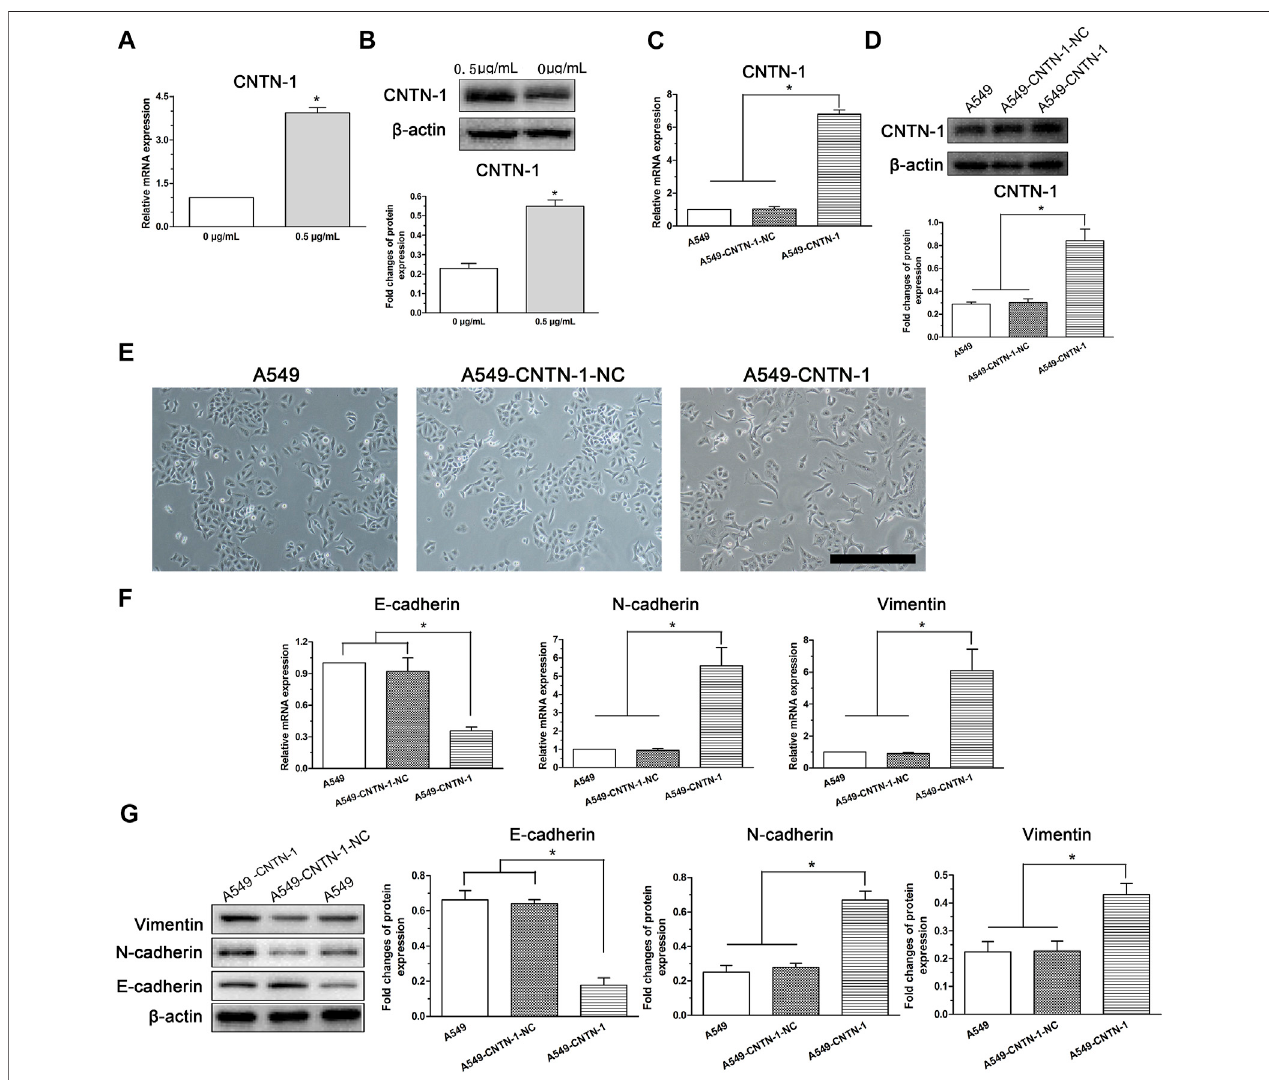
FIGURE 4 | EMT progression of A549 cells induced by low-dose cisplatin treatment related to CNTN -1 expression. (A,B) CNTN -1 was evaluated by RT-PCR and Western blot, respectively. CNTN -1 was upregulated in A549 cells treated with low-dose cisplatin (0.5 μ g/ml) compared with that of controls (* p < 0.05). (C,D) CNTN -1 overexpression in A549- CNTN -1 cells was veri fi ed by RT-PCR and Western blot, respectively. CNTN -1 was successfully overexpressed in A549- CNTN -1 cells both at geneandproteinlevels(* p < 0.01). (E) EMTphenotypeobservedinA549- CNTN -1cells(magni fi cation:×100,scalebar=100 um). (F,G) EMT-relatedmarkerswere detected in A549- CNTN -1 cells. Both N-cadherin and vimentin were increased whereas E-cadherin was decreased both at gene and protein levels in A549- CNTN -1 cells (* p < 0.01). Each experiment was conducted in triplicate and the data were expressed as mean ±